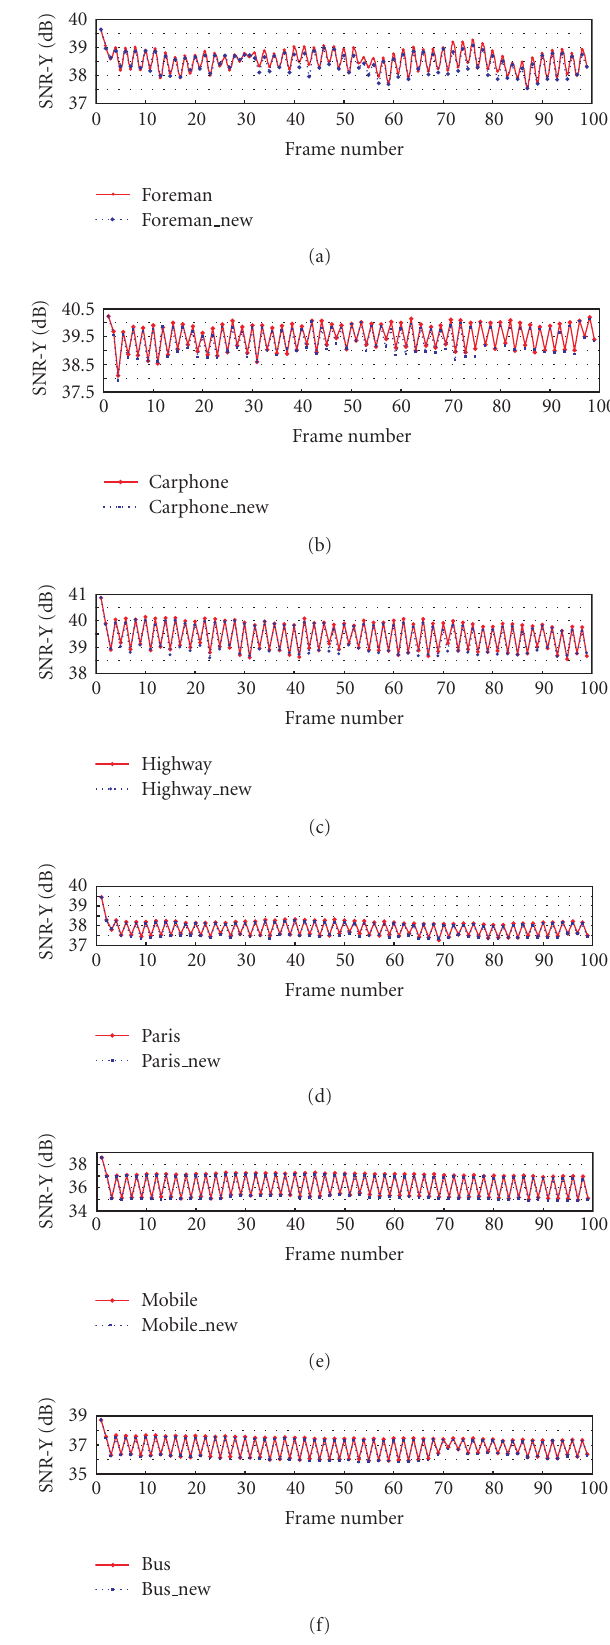
Figure 4: PSNR-Y comparisons of six test